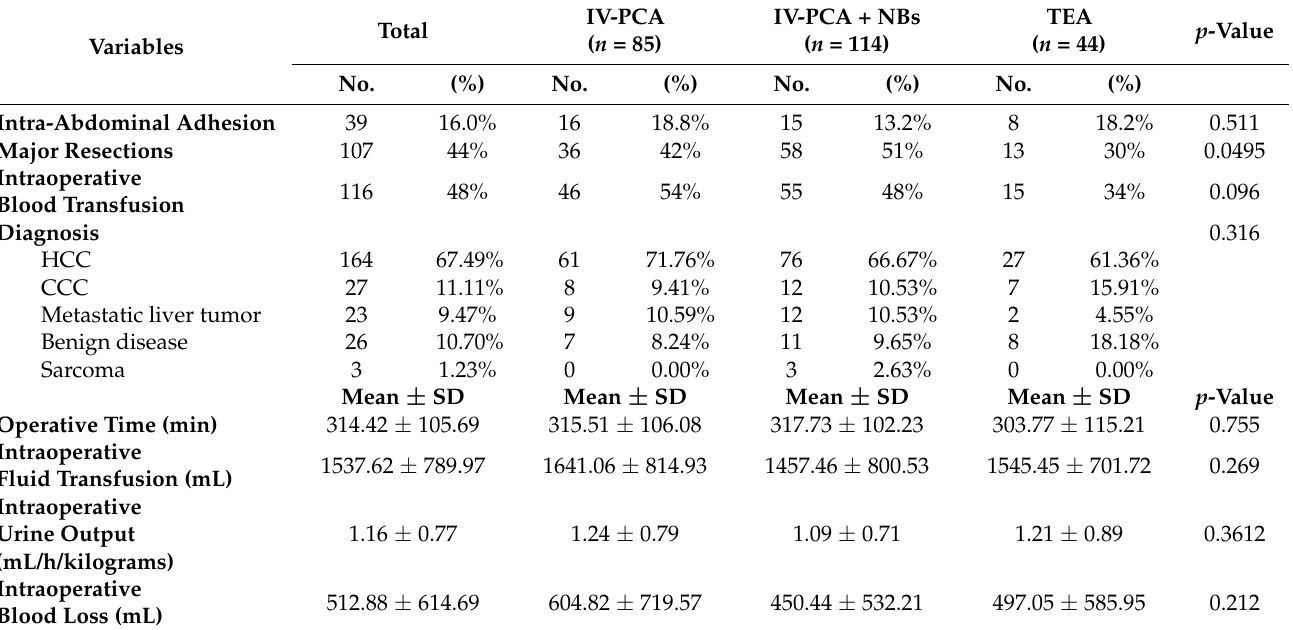
Table 2. Perioperative parameters ( n =